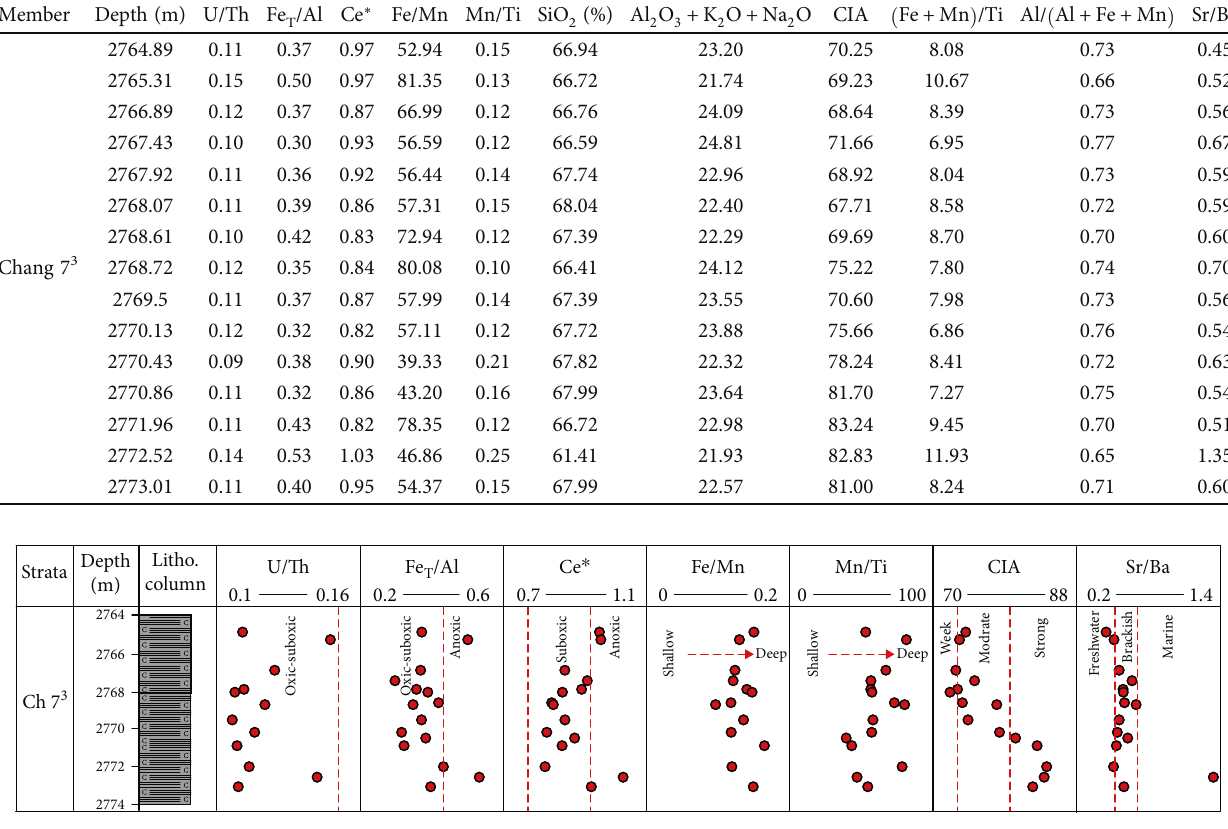
Figure 8: Element geochemical column of Chang 7 3 black shale in well DP1 showing paleoenvironment, paleowater depth, chemical weathering, and paleosalinity. Note that the dashed lines indicate the thresholds for these geochemical proxies.